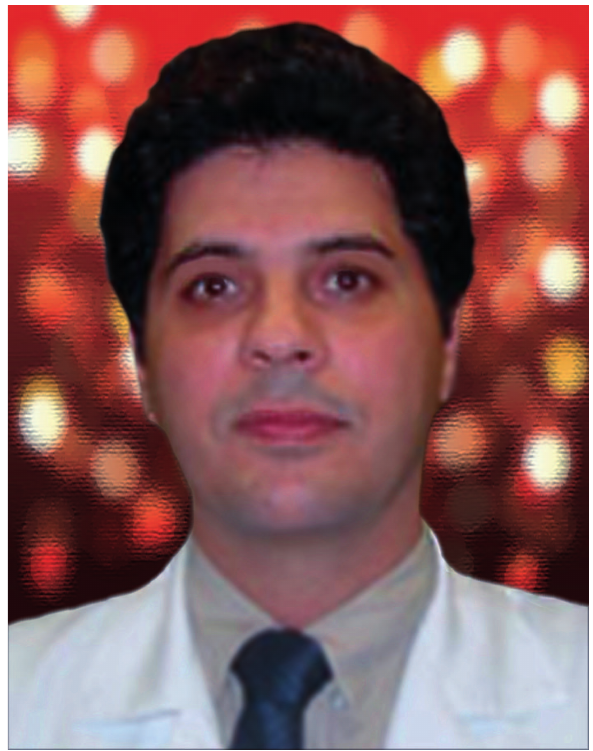
Fig. 1 - Gerola: médico brilhante e lutador incansável pela